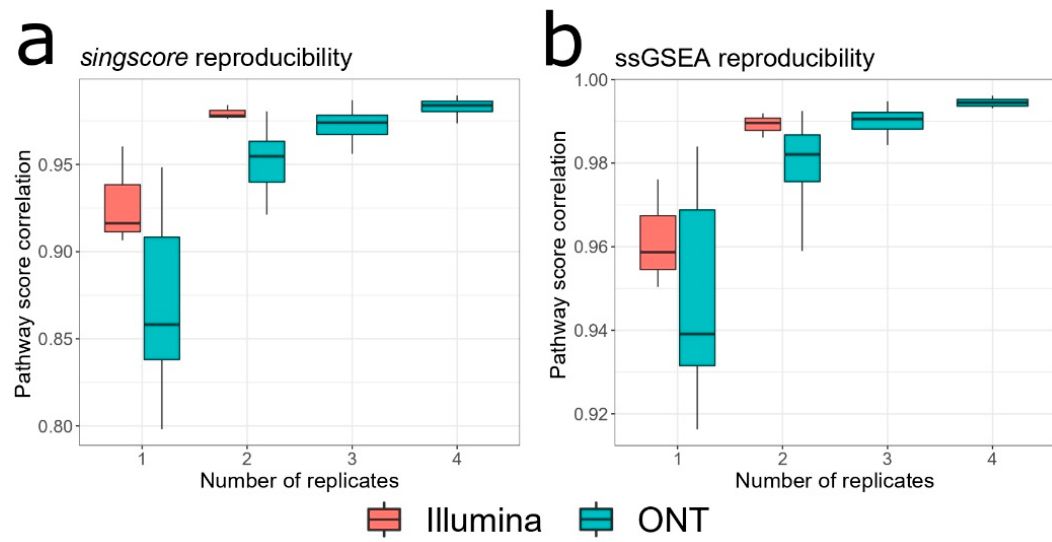
Figure 4. Pairwise correlation between pathway scores. Different combinations of experimental replicates ONT-1, . . . , ONT-5 and ILMN-1, . . . , ILMN-3 were generated. For every two combinations, pathway activation scores were estimated. Distribution of Spearman correlation coefficients between pathway scores using either singscore ( a ) or ssGSEA ( b ) algorithms was plotted for each number of replicates.